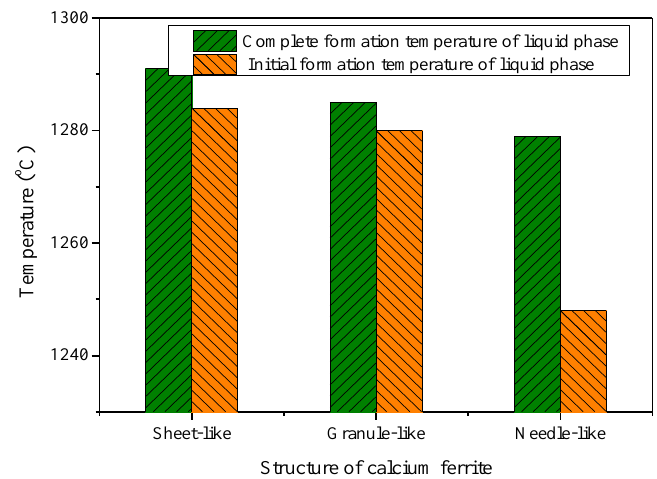
Figure 14. Relationship between the structures of SFCA and the liquid formation temperatures of SFCA.